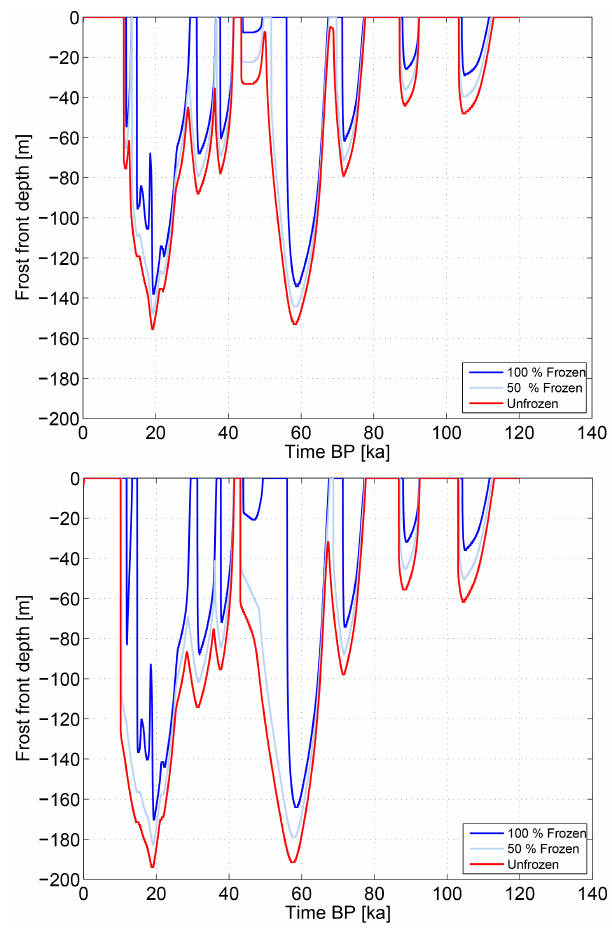
Figure 5. Top: best estimate permafrost progradation during a sim- ulation of the Weichselian glaciation cycle for the FRP polygon. Bottom: idem, for the LBH polygon. These two polygons (FRP and LBH) are at the low and high end of the resulting permafrost depths respectively.